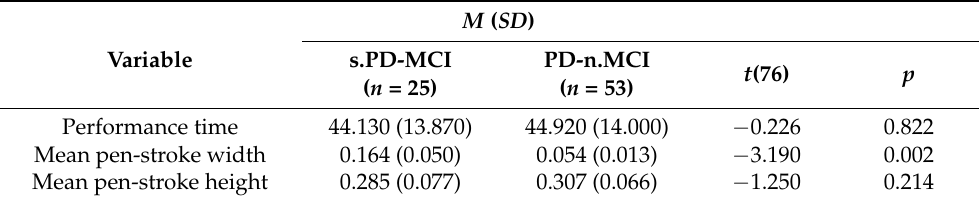
Table 2. Comparison of the objective measures of the handwriting fill-in-a-check task of s.PD-MCI and PD-n.MCI patients.